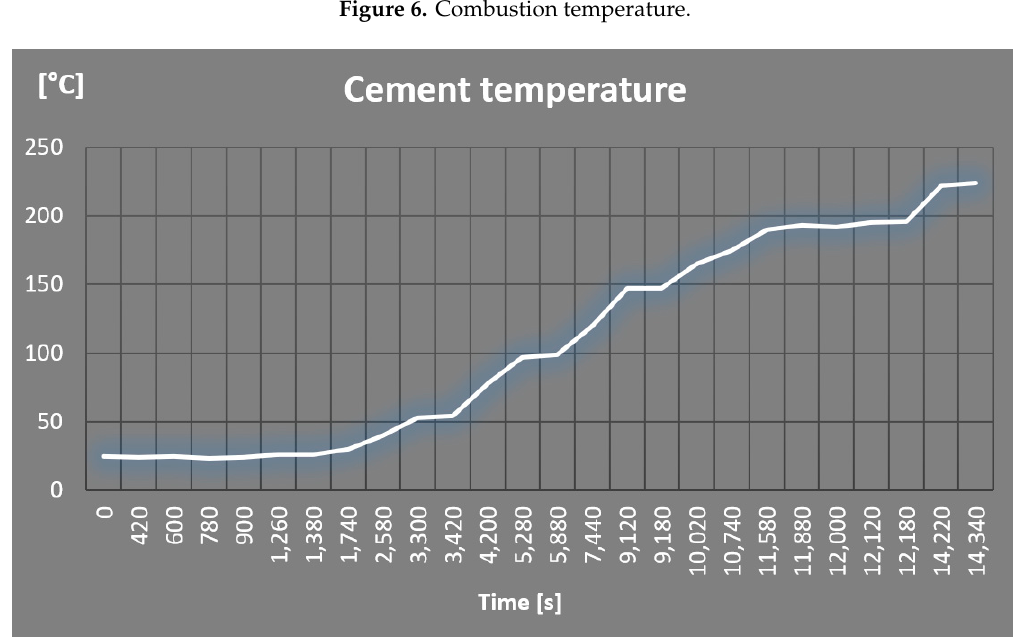
Figure 7. Trend of the temperature of the cement that surrounds the combustion chamber.